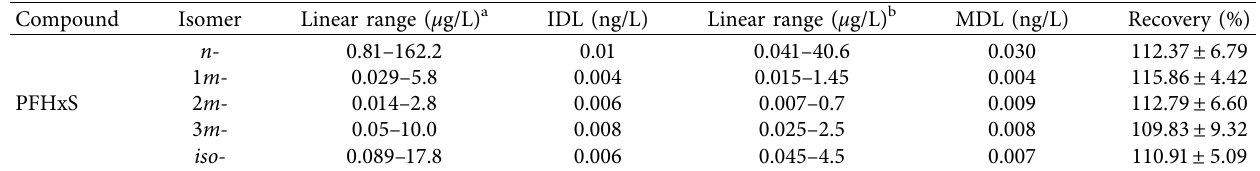
Table 4: Quality control parameters for PFHxA isomers.